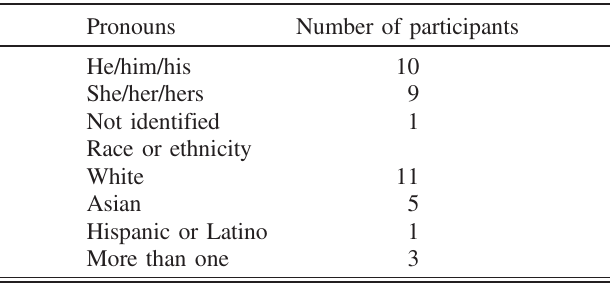
TABLE II. Demographic information of LA